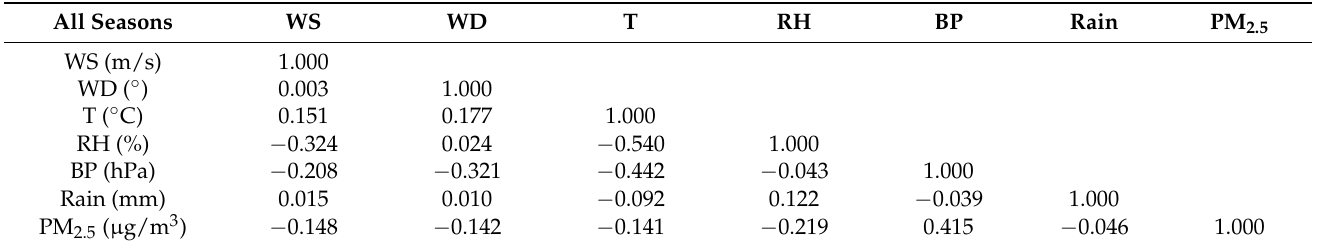
Table 1. Correlations between PM 2.5 concentration and meteorological factors obtained at a height of 30 m from 2015 to 2020.